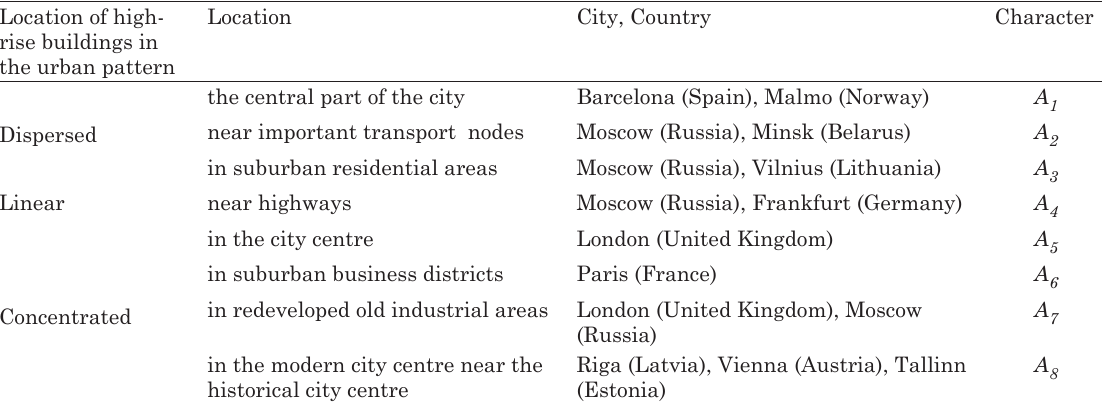
table 1. location models for high-rise buildings in european cities location of high- rise buildings in